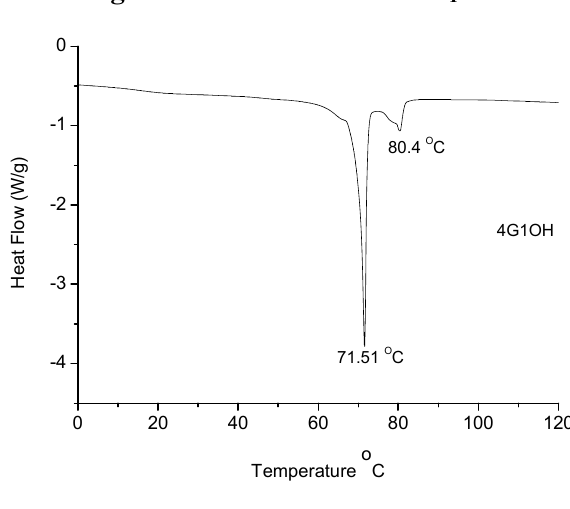
Figure 3. DSC of dendron 4G